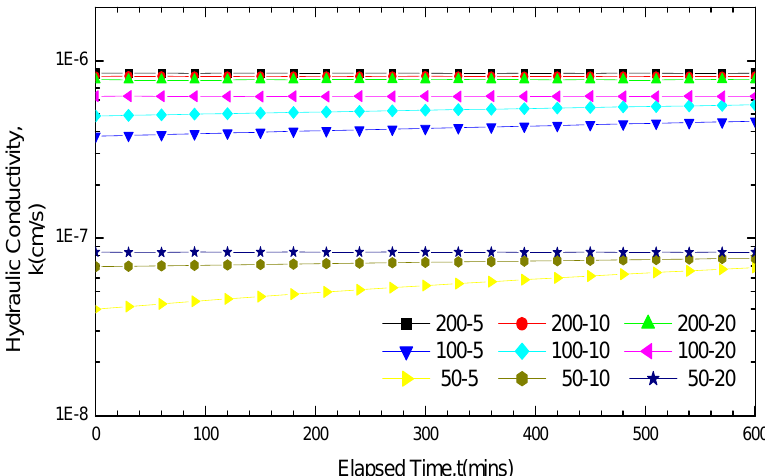
Figure 6. Hydraulic conductivity results for GCL specimens soaked and permeated with MgCl solution. 2